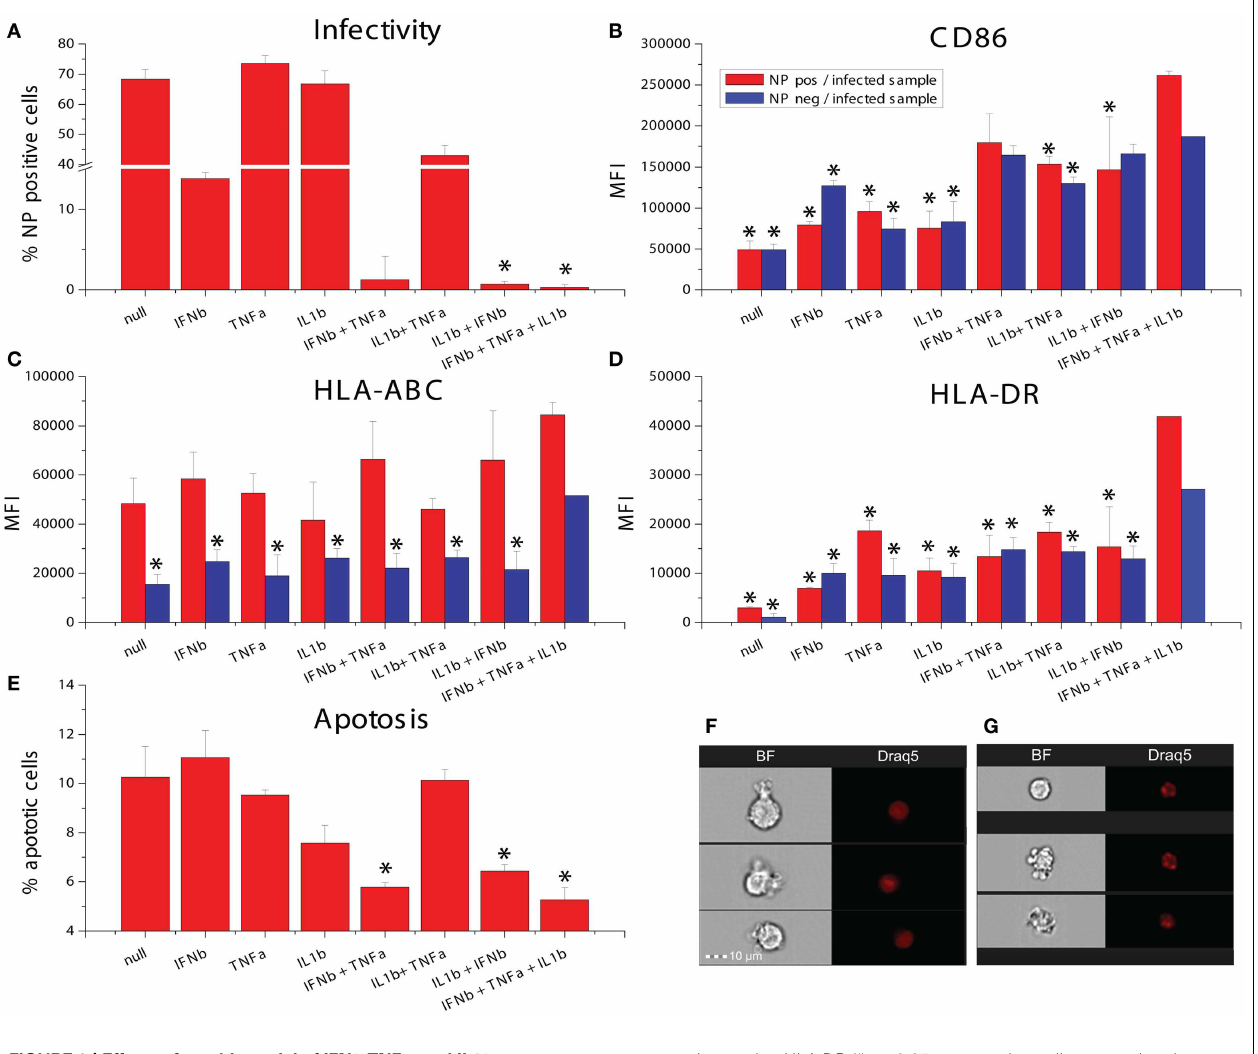
FIGURE 9 | Effects of combinatorial of IFN β ,TNF α , and IL1 β treatment on DCs infected with the pandemic influenzaA Cal/09 strain . (A) Infectivity assayed by NP expression (* p ≤ 0.05 compared to cells exposed to IFN β ). (B) Expression of the maturation marker CD86. (C) Expression of the maturation marker HLA-ABC. (D) Expression of the